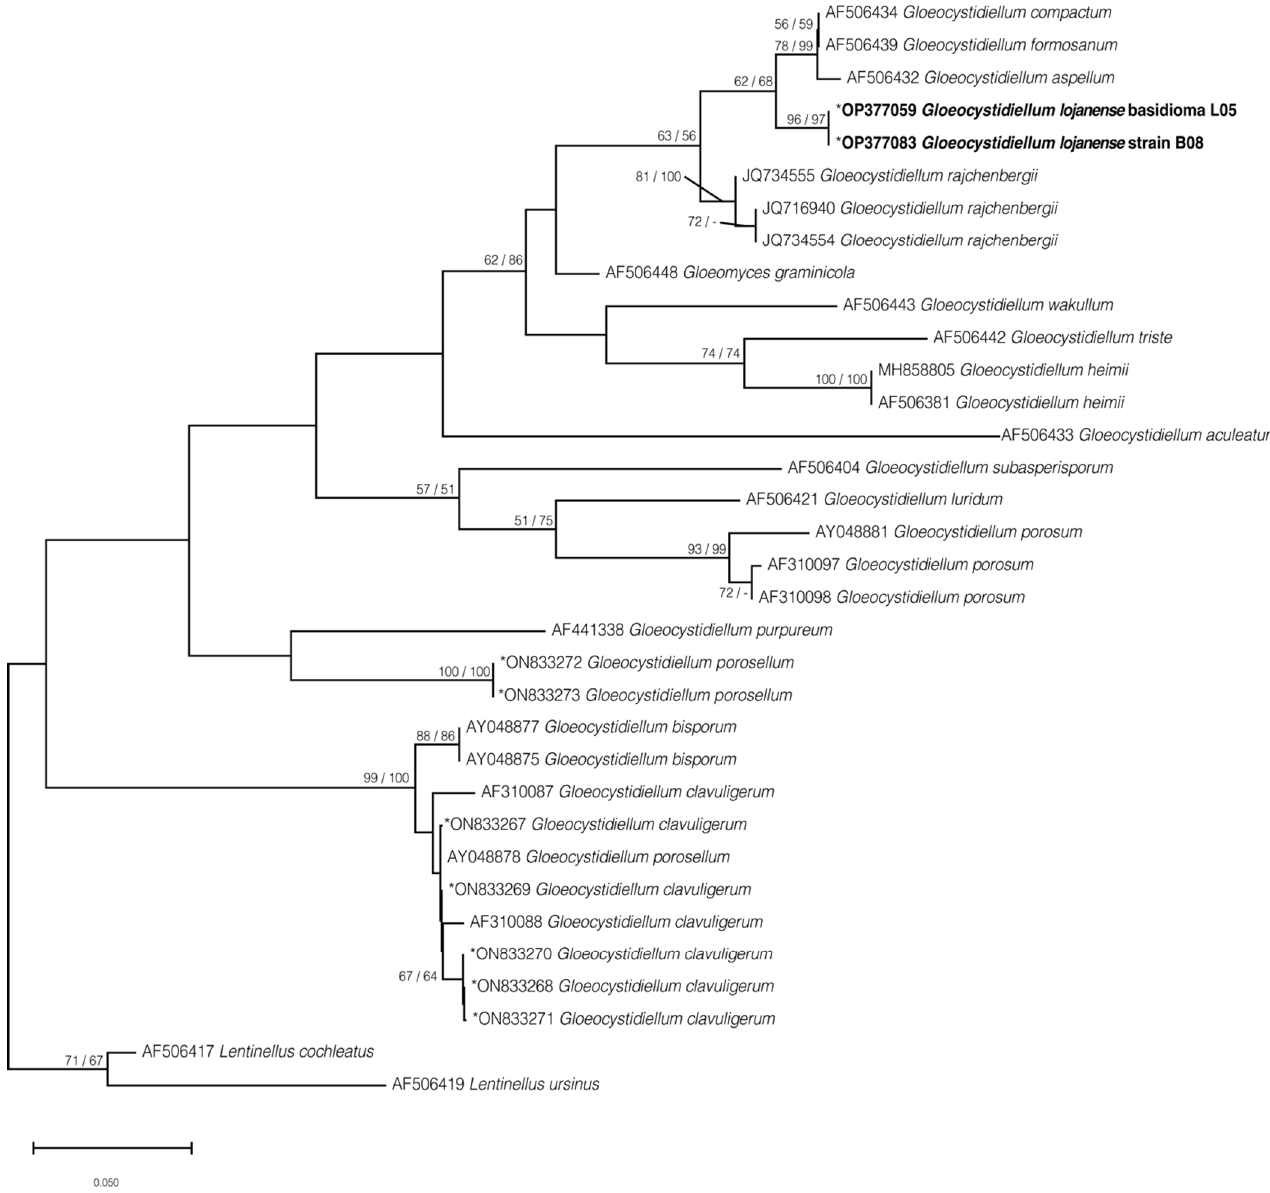
Figure 5. Maximum likelihood phylogenetic tree for the ITS1 region for sequence positioning corresponding to Gloeocystidiellum lojanense sp. nov. and positioning of Gloeocystidiellum rajchenbergii . Values on the nodes correspond to ML and NJ, respectively. Bar = number of expected substitutions per position. * Sequences generated in this study. Sequences and accession numbers of the new species are in bold.